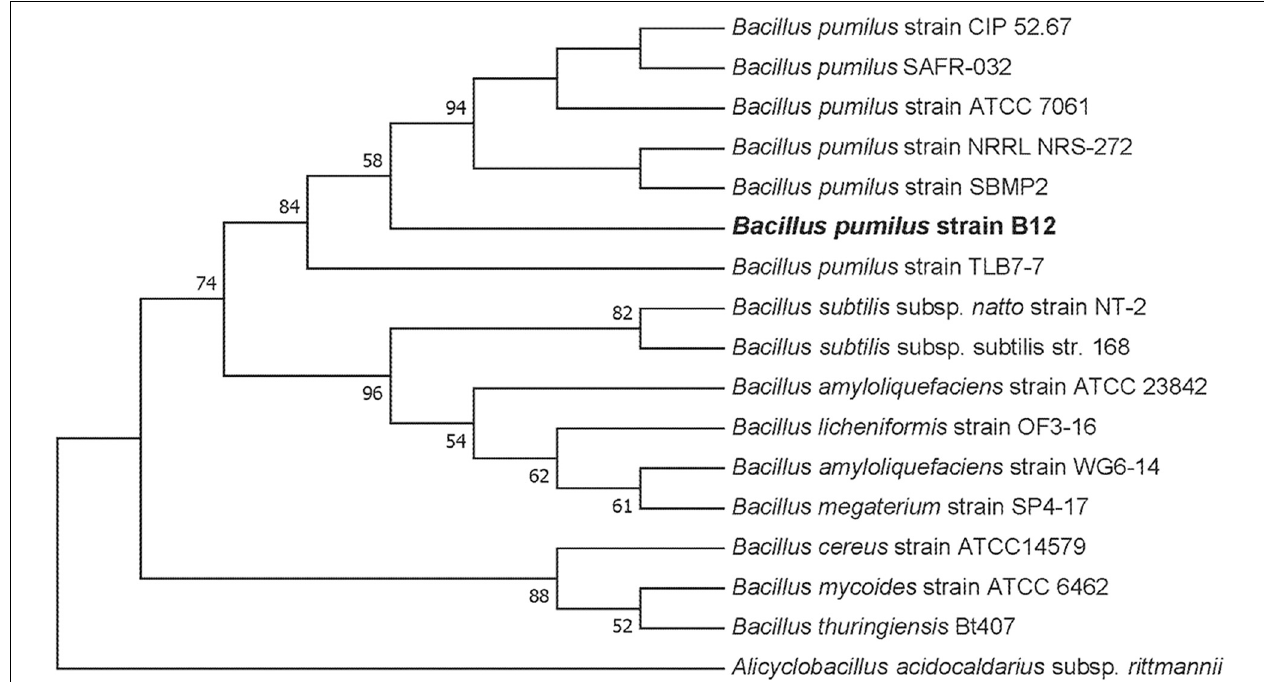
FIGURE 3 | Maximum likelihood phylogenetic tree of 16S rDNA for the environmental isolate B12 compared to other Bacillus spp. This bootstrap consensus tree was constructed with 500 replicates. Bootstrap values were used as confidence values for the nodes. Nucleotide sequences for the other bacteria were retrieved from NCBI. The accession numbers are as follows: Bacillus amyloliquefaciens (HQ874610.1), Bacillus megaterium strain SP4-17 (HQ874615.1), Bacillus licheniformis strain OF3-16 (HQ874614.1), Bacillus amyloliquefaciens strain ATCC 23842 (EU689157.1), B. subtilis strain DSM10 (AJ276351.1) , Bacillus licheniformis strain HSP-1 (HQ874617.1), B. subtilis subsp. natto strain NT-2 (HQ874611.1), B. subtilis ATCC 6633 (AB018486.1), B. pumilus strain TLB7-7 (HQ874616.1), B. pumilus strain ATCC 7061 (AY876289.1), B. pumilus strain NBRC 12092 (NR_112637.1), B. pumilus strain CIP 52.67 (NR_115334.1), B. pumilus strain NRRL NRS-272 (NR_116191.1 ), B. pumilus strain SBMP2 (NR_118381.1), Bacillus cereus strain ATCC11778 (AF290546.1), Bacillus cereus strain ATCC14579 (AF290547.1), Bacillus mycoides strain ATCC 6462 (EF210295.1), Bacillus thuringiensis Bt407 (ACMZ01000011.1), and Alicyclobacillus acidocaldarius subsp. rittmannii